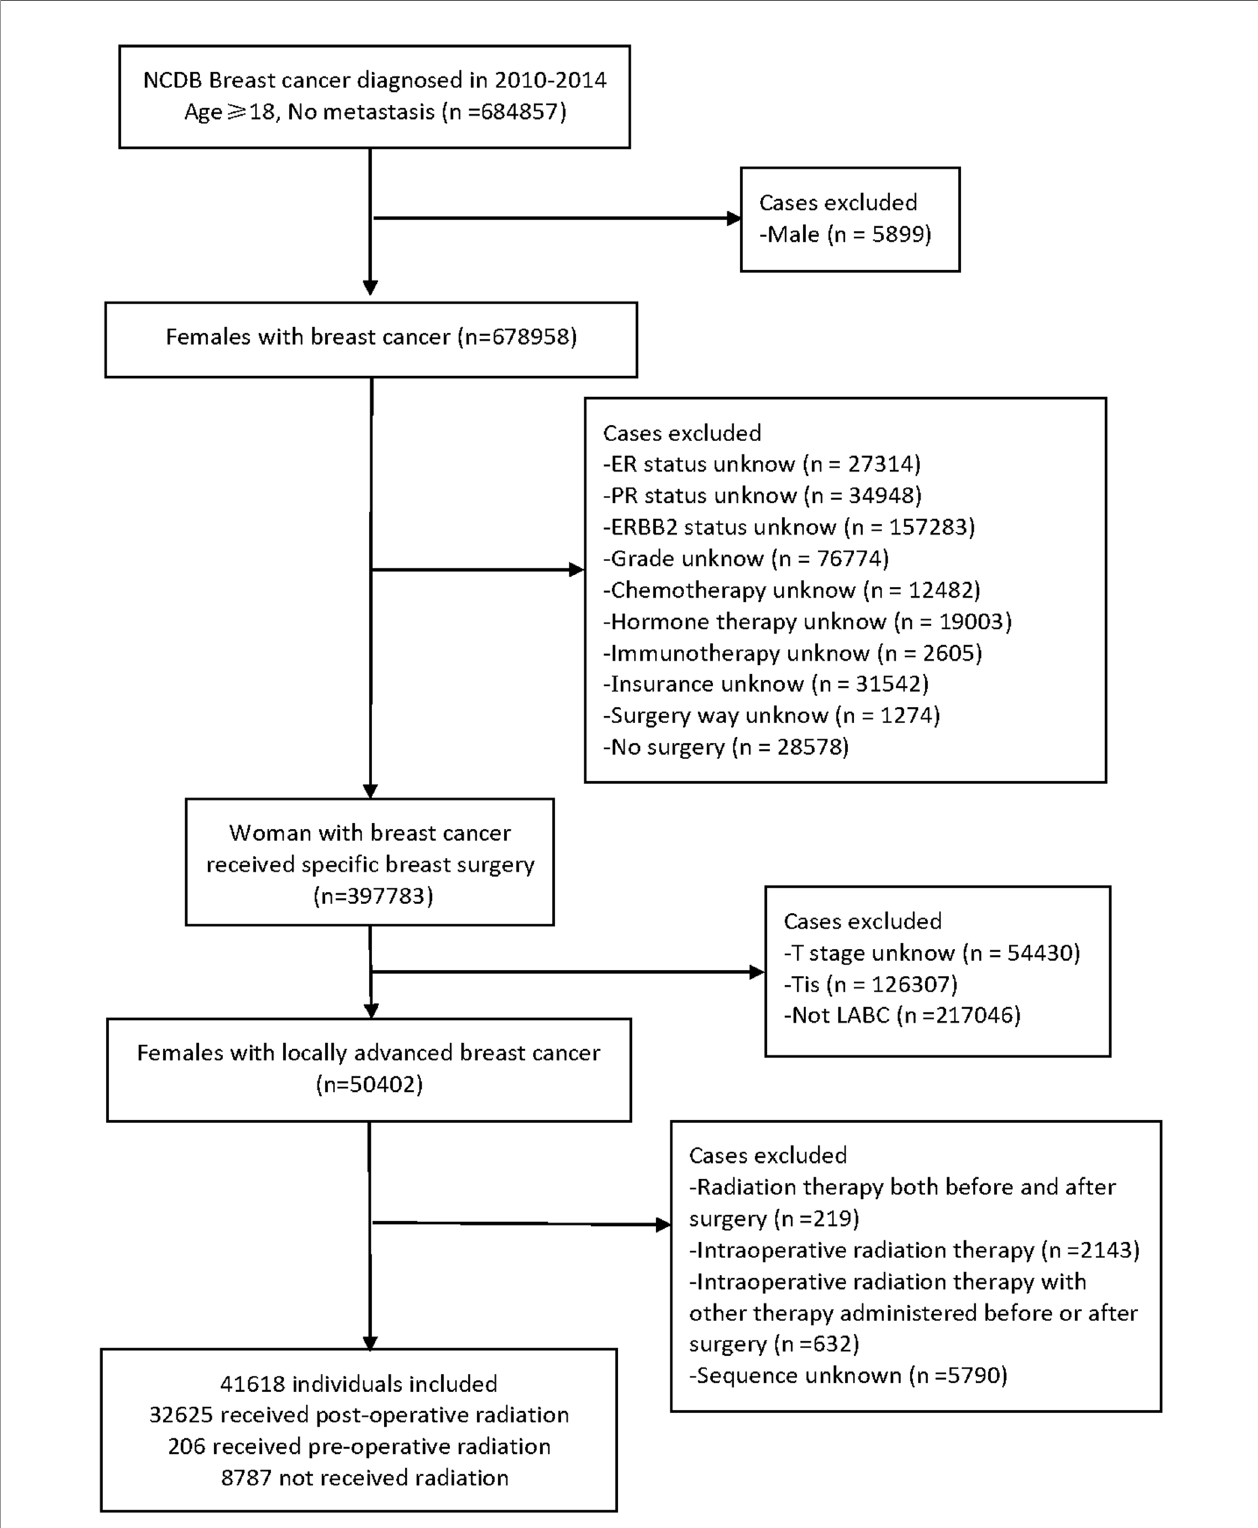
FIGURE 1 | Flow Chart of participants Selection in National Cancer